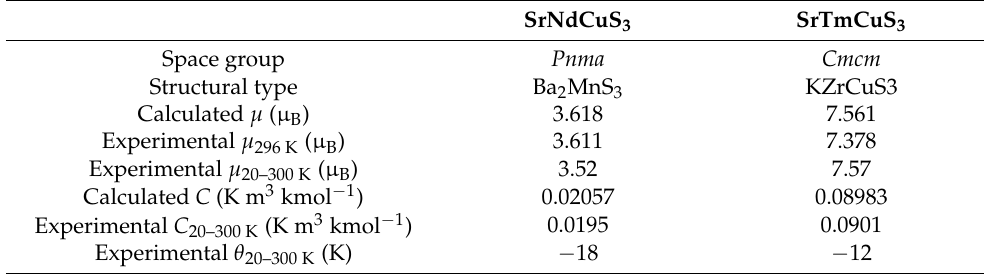
Table 5. Magnetic characteristics for SrNdCuS 3 and SrTmCuS 3